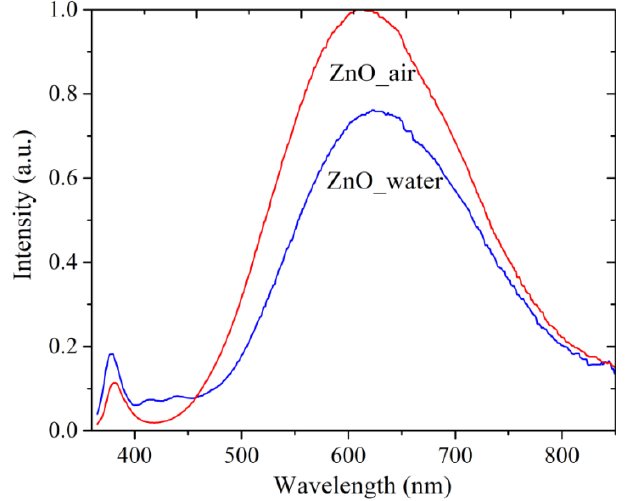
Figure 6. PL spectra of samples PLA-generated in air (red line) and water (blue). Excitation source use had λ ex = 350 nm.